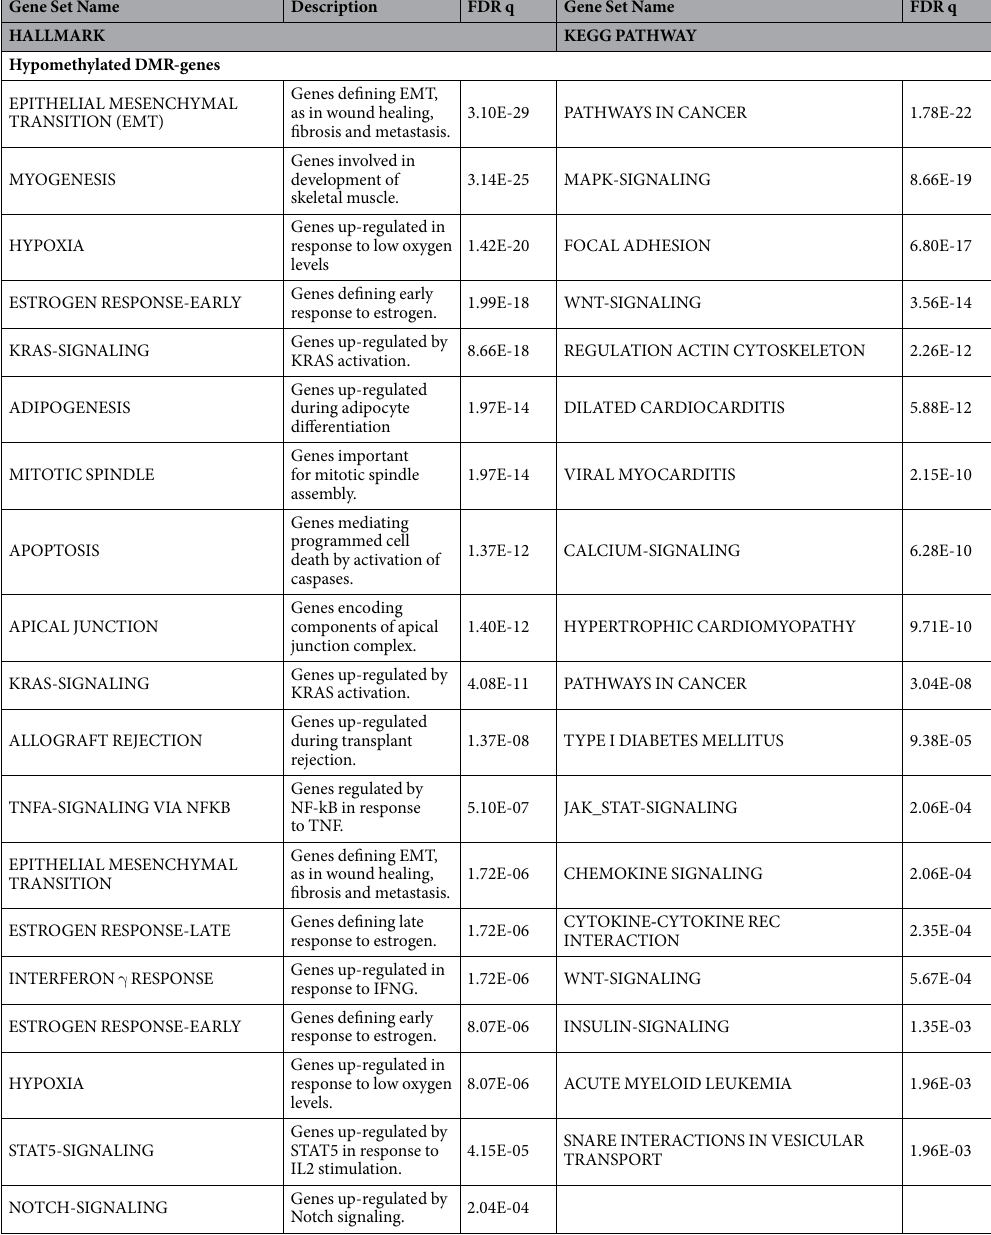
Table 2. Hallmark and KEGG pathway analysis of BAV hypo- and hypermethylated DMR-associated genes, dilated